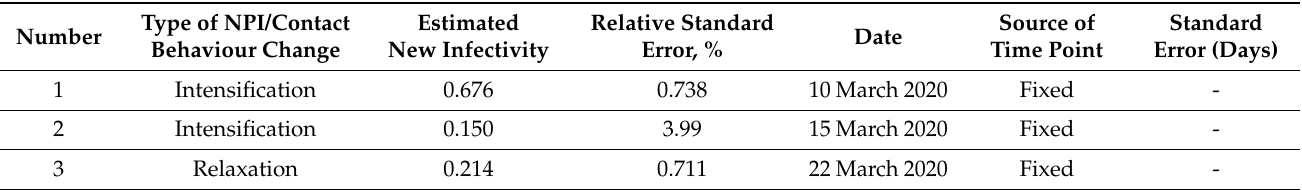
Table A1. Time points of changes in infectivity and respective steps. We used fixed (known due to Governmental decisions or random events) and estimated time points of NPI/contact behavior changes and events and respective changes in infectivity of asymptomatic subjects. We provide estimates and relative standard errors of the infectivity. For estimated time points, we also provide the respective standard error (last